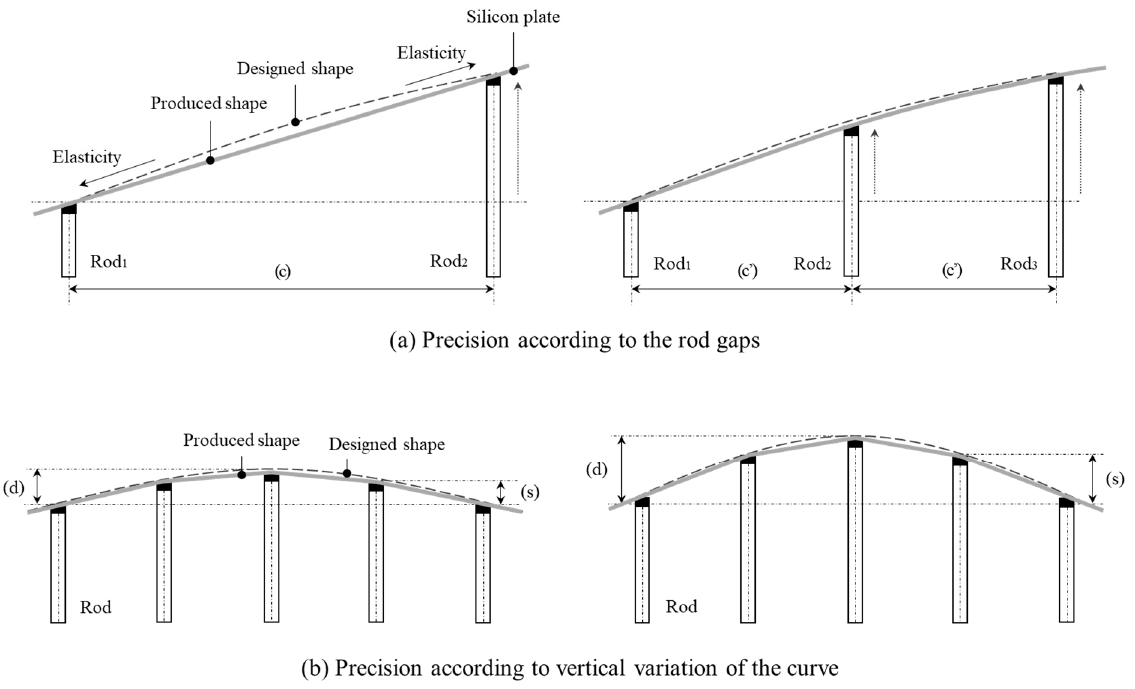
Figure 2. Errors between the shapes of the designed and produced panels.